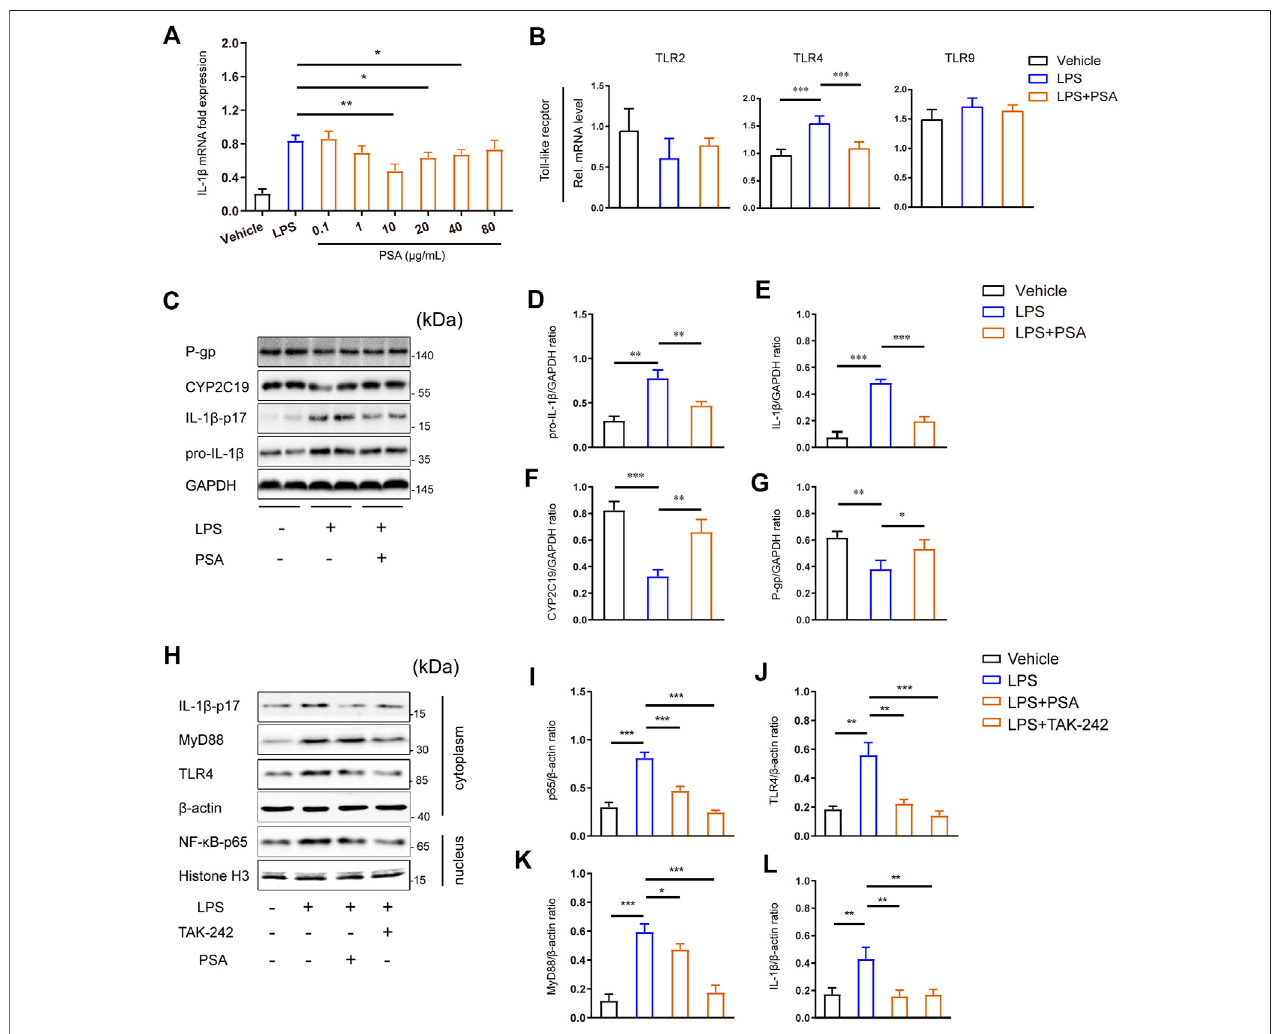
FIGURE6| PSAinhibitsthesecretionofIL-1 β maythroughTLR4signalpathway. (A) OptimumPSAconcentrationselectionbasedonthemRNAexpressionlevels of IL-1 β . (B) mRNA levels of key toll-like recepters in the liver ( n (cid:1) 6 – 12). (C – G) Immunblots (C) and densitometric analysis of pro-IL-1 β (D) , IL-1 β -p17 (E) , CYP2C19 (F) and P-gp (G) in liver tissue homogenates treated with the vehicle, LPS and LPS + PSA. (G – K) , Immunblots (H) of key proteins of TLR4 signal transduction and densitometric analysis of these proteins (I – L) in primary hepatocyte treated with the vehicle, LPS, LPS + PSA and LPS + TAK-242. Western blot results are representative of three independent experiments. * p < 0.05, ** p < 0.01, *** p < 0.001, Unpaired t test.